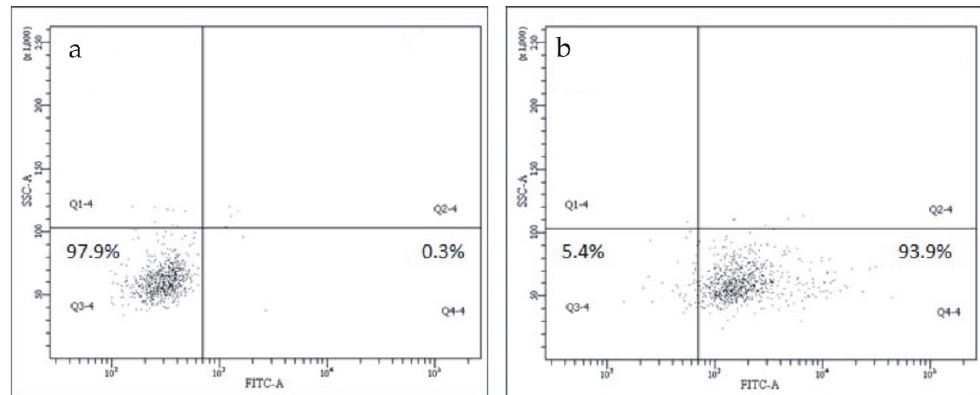
Figure 4. CRP detection on CD45 / CD14-positive monocytes. ( a ) The binding of the non-specific FITC-labeled mouse IgG to CD14-positive monocytes; ( b ) the binding of FITC-labeled monoclonal antibody to pCRP to CD14-positive monocytes. pCRP—pentameric C-reactive protein.